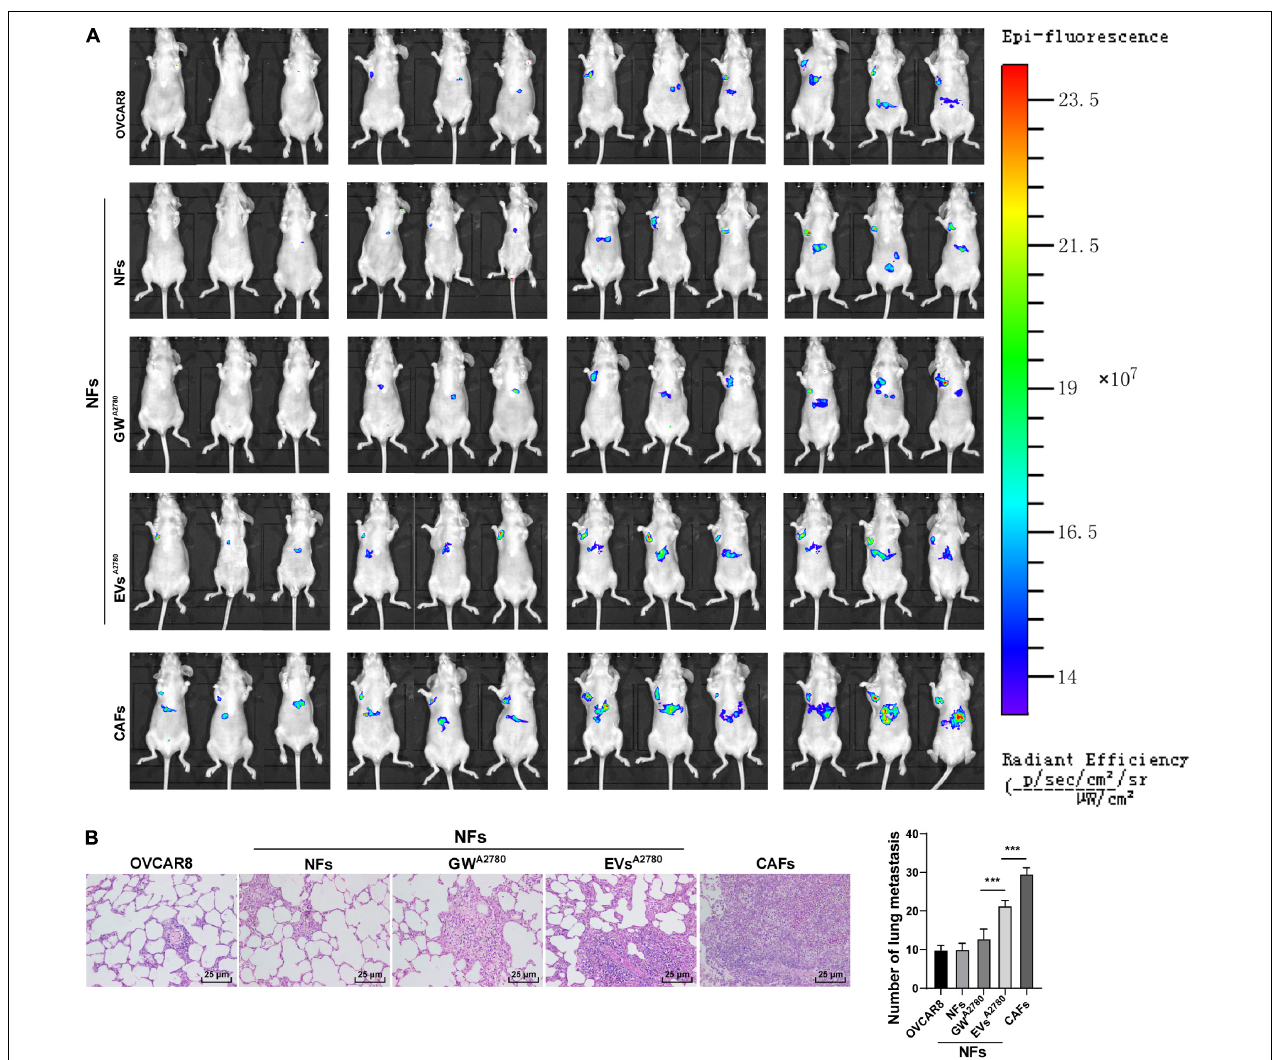
FIGURE 9 | Extracellular vesicles induced CAF activation and promoted OC metastasis in vivo . Lung metastasis model of OC in nude rat was established by injecting OVCAR8 cells in different groups via tail vein. On the 1st day after operation, mice were continuously administered the conditioned medium of untreated or EVs-treated NFs and untreated CAFs, respectively. (A) Growth and organ metastasis of OC xenografts in mice were observed using small animal imaging technology; (B) lung metastasis area of OC was detected using HE staining, and the number of lung metastases was observed under the microscope. N = 6. Data are presented as mean ± standard deviation. Data in panel (B) were analyzed using one-way ANOVA, followed by Tukey’s multiple comparison test, *** p <